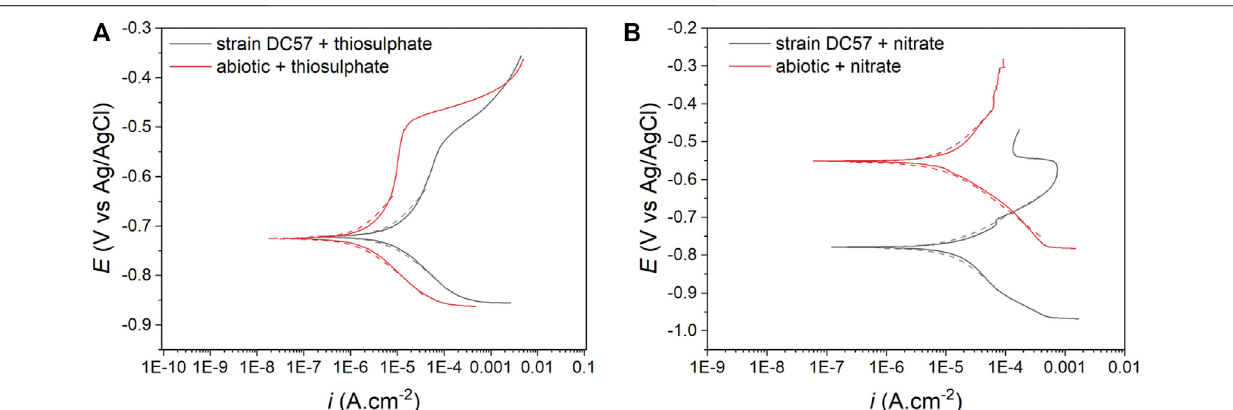
FIGURE 4 | Potentiodynamic polarization curves after 16-days exposure to thiosulphate (A) and nitrate (B) reducing conditions, dashed lines represent the Tafel fi